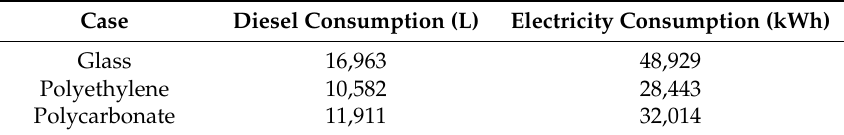
Table 8. Annual energy consumption of each